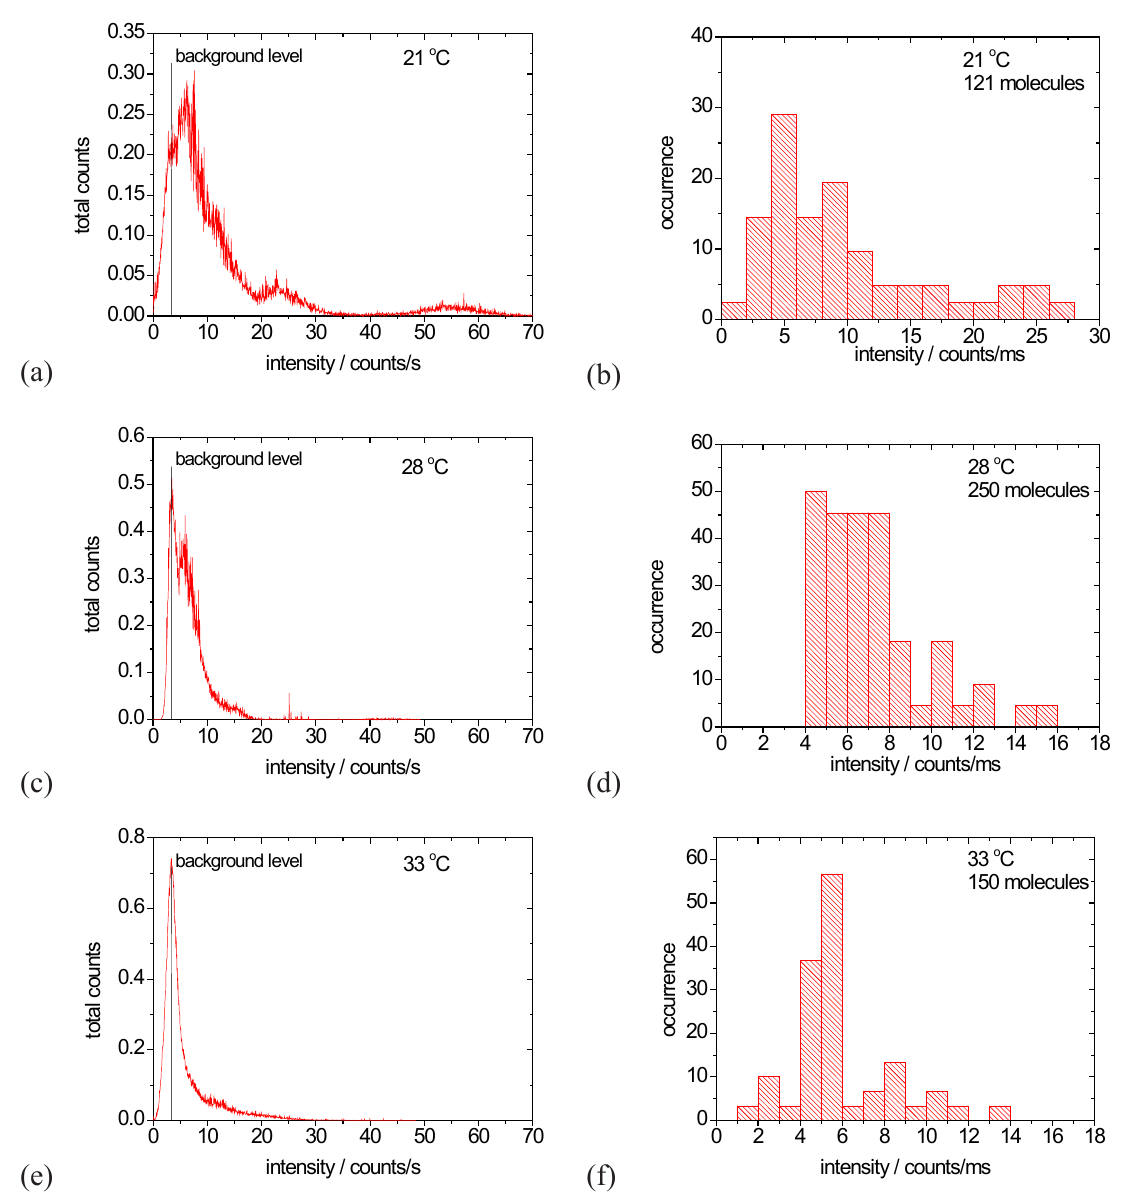
Figure 8. Average fluorescence intensities of molecules 1; (a), (c) and (e) weighted sum of the fluorescence intensity histograms of single molecules at 21°C, 28°C and 33°C respectively; (b), (d) and (f) histograms of average intensities of single molecules at 21°C, 28°C and 33°C respectively. The measurements at 21°C were performed using 10 times lower excitation probed at 21, 28 and 33°C. The results indicate that there is indeed strong evidence for dependence of the average emission intensities of molecules on their dynamics. Figs. 8a, 8c and 8e show the weighted sum of the fluorescence intensity histograms (cf. Fig. 7) of individual molecules. The weights normalize the total number of counts in the fluorescence histogram of each molecule to assure the same influence of each molecule on the overall statistics.